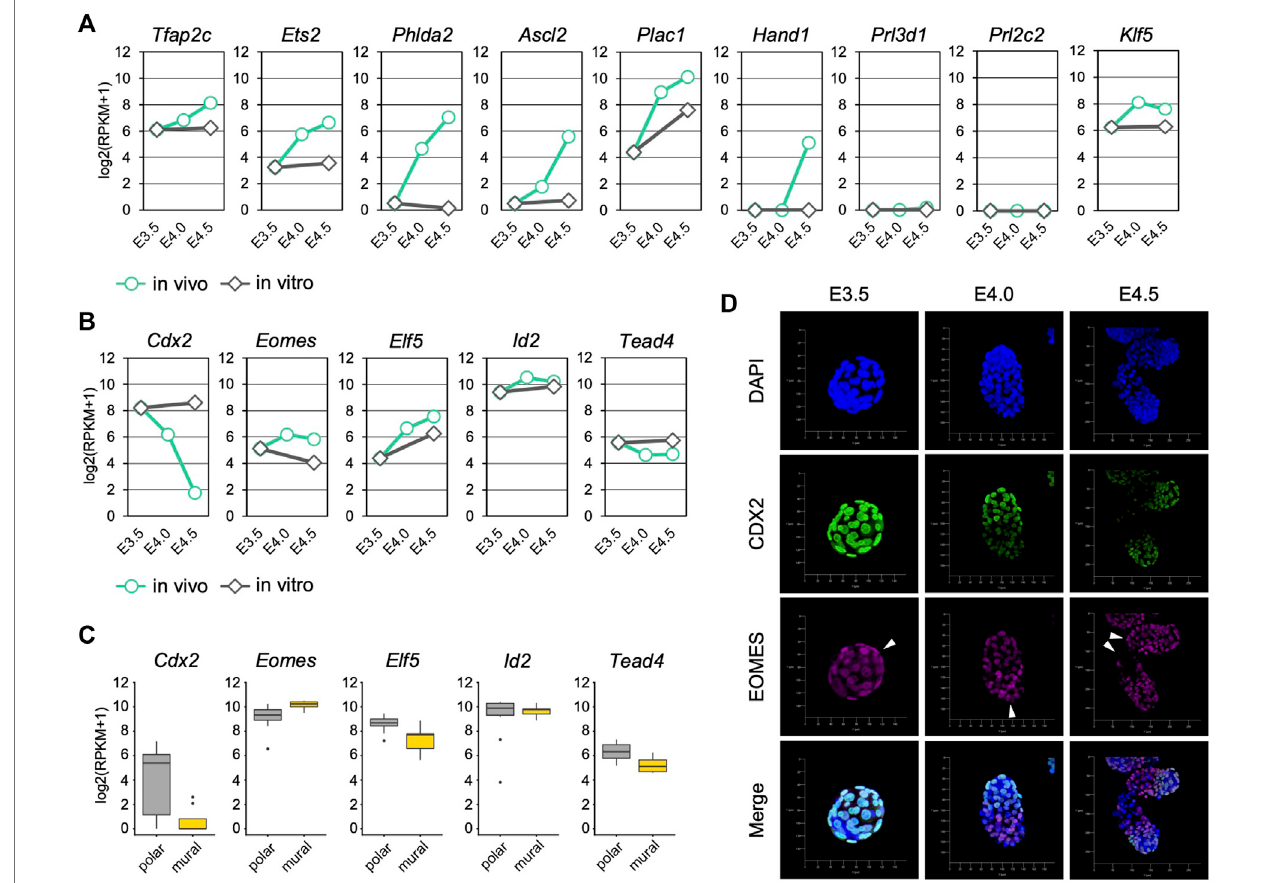
FIGURE 2 | Trophoblast marker gene expression in the mTE during implantation (A) mRNA levels of differentiation marker genes detected by RNA-seq analysis in mTE (B) mRNA levels of undifferentiation marker genes detected by RNA-seq analysis in mTE (C) mRNA levels of undifferentiation marker genes in each cell of the pTE and mTE. These results were obtained by re-analyzing the published single-cell RNA-seq datasets of E4.5 blastocysts (D) Immunostaining of CDX2 and EOMES in blastocysts at E3.5, E4.0 and E4.5. Arrowheads indicate the tips of the mTE. Scale bar: 50 µm.